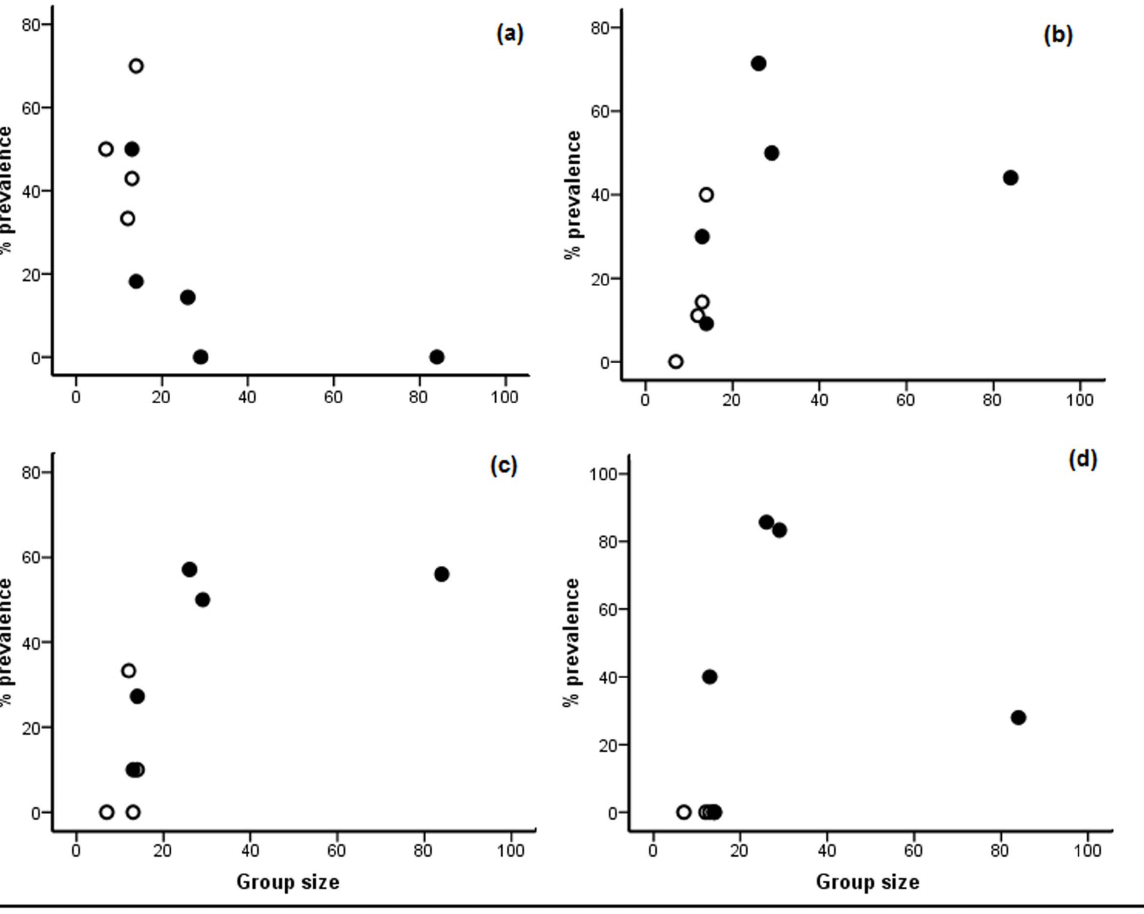
Figure 2. The relationship between parasite prevalence and group size in the lion-tailed macaque in nine forest fragments; (a) Ancylostoma , (b) Strongyloides , (c) Trichuris and (d) Bunostomum ; fragments ( N ) with or (O) without human settlements.